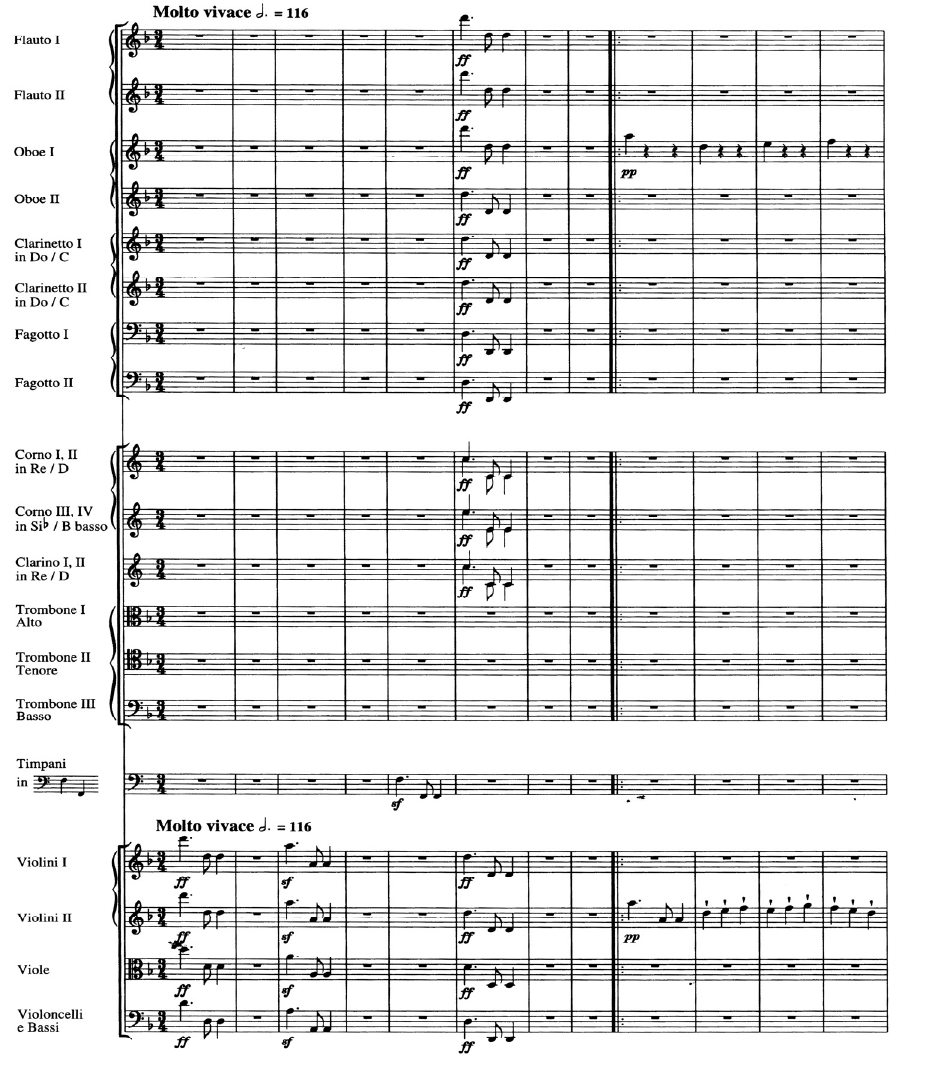
Figure 4. Ludwig van Beethoven, Symphony No. 9 in D Minor, Op. 125, Second movement. Urtext edited by Jonathan Del Mar, Kassel: © 1999, Bärenreiter-Verlag. Molto vivace , scherzo, mm. 1–12. Used with permission of Bärenreiter-Verlag , Kassel